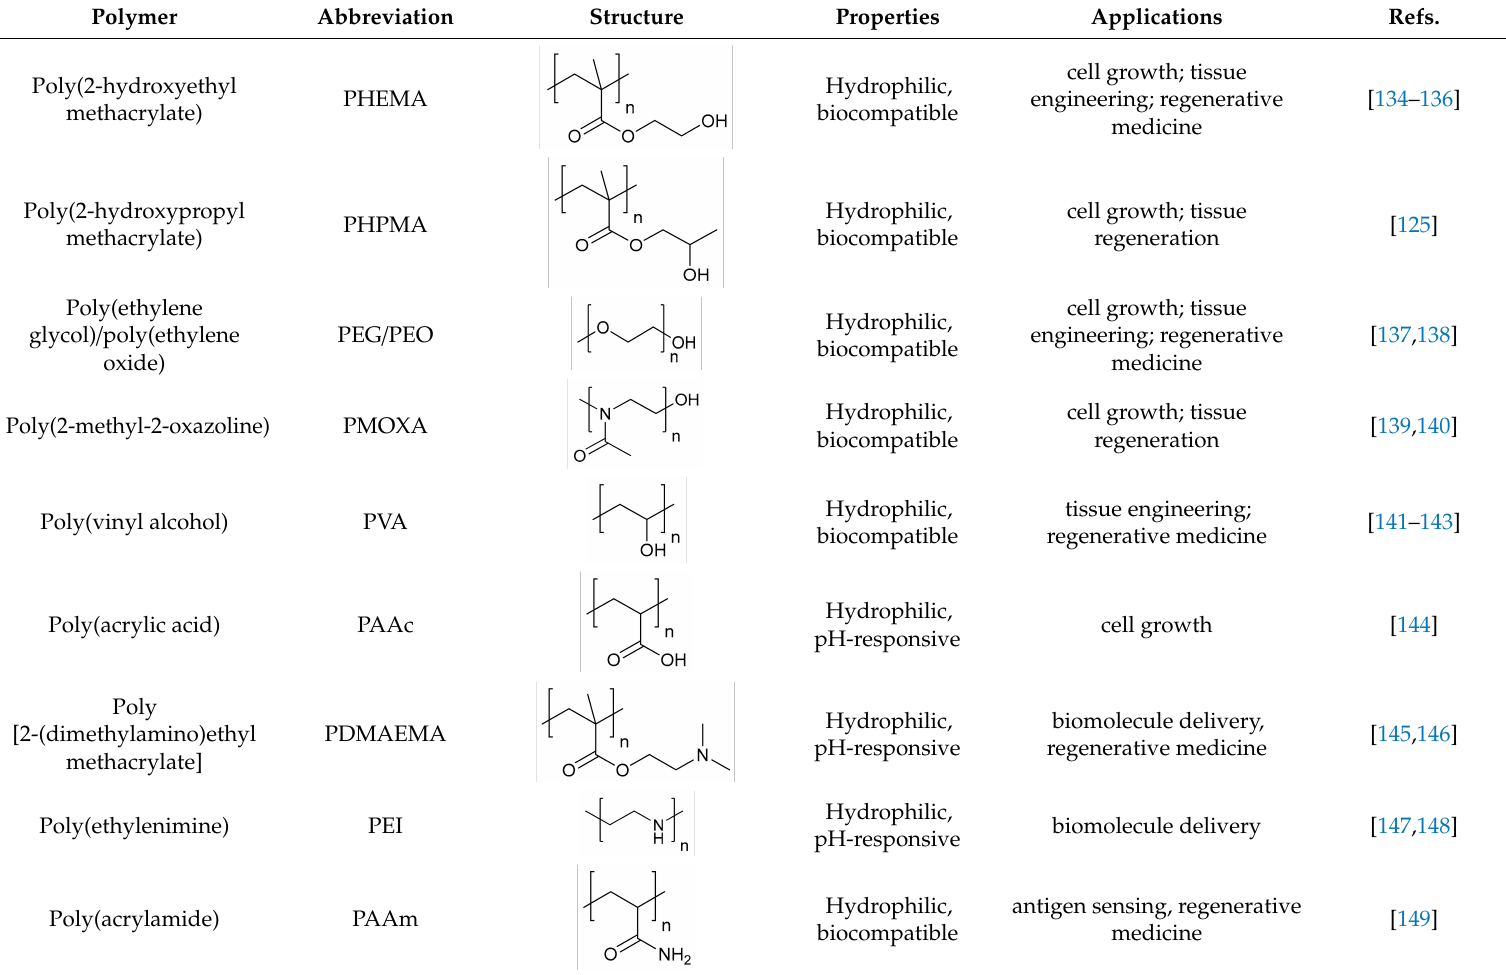
Table 1. The most relevant polymers involved in preparation of hydrogels for biomedical